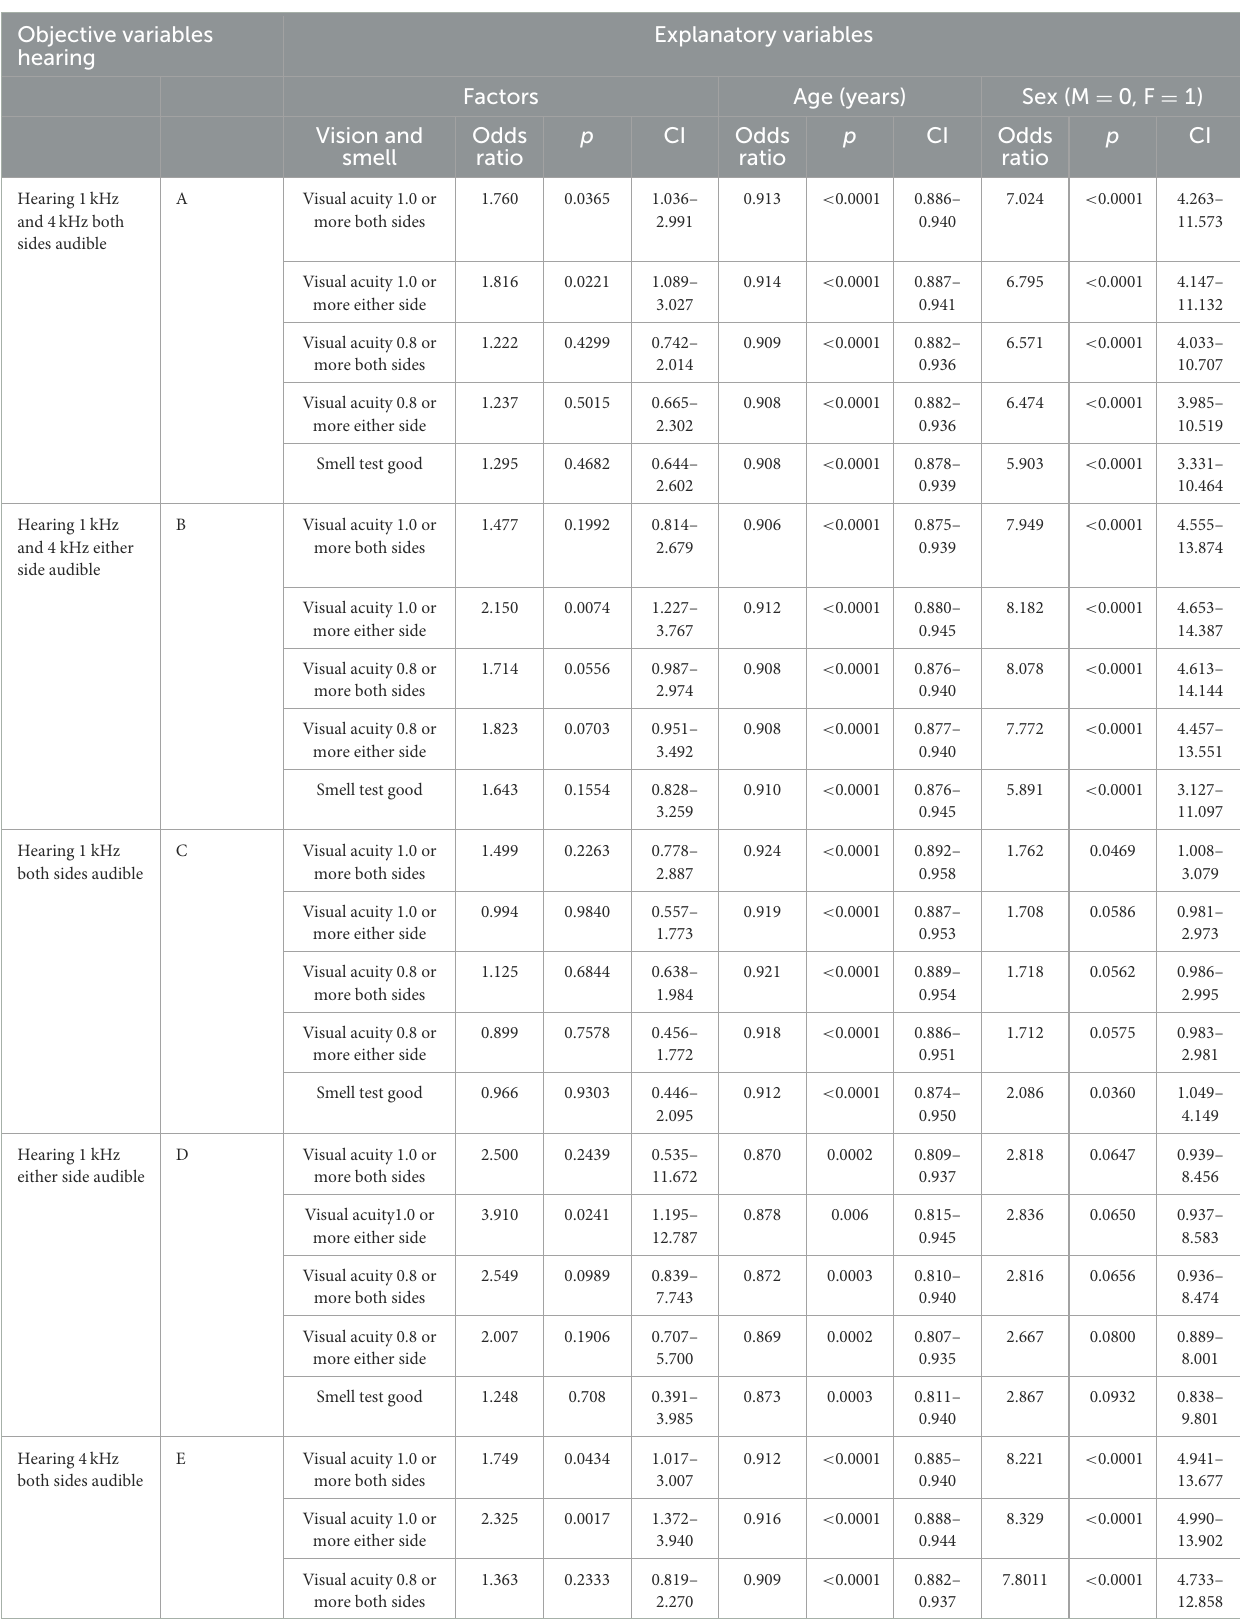
TABLE 6 Relationship between hearing test and olfactory and vision tests (logistic regression